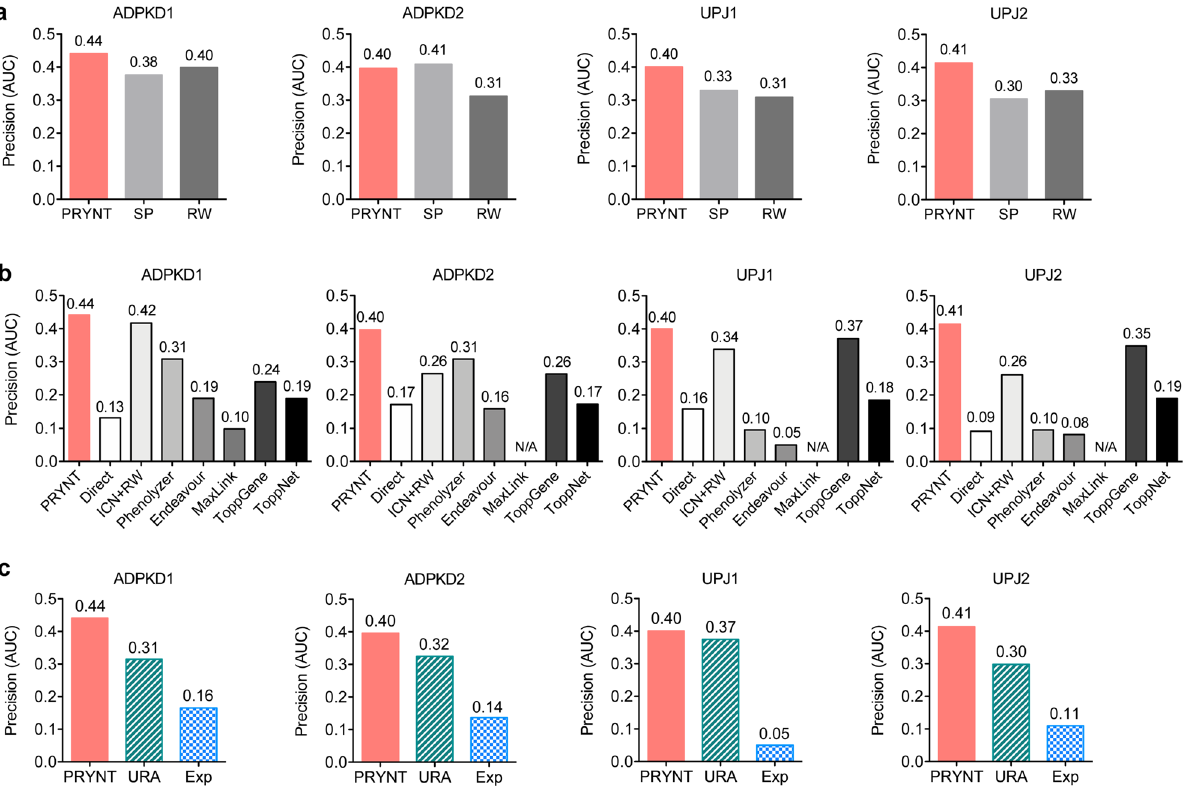
Figure 4. Performance of PRYNT compared to other approaches. PRYNT performance was compared to prioritization using shortest-path or random walk algorithms alone ( a ), to prioritization by other common, state of the art prioritization strategies ( b ), or to prioritization by reference approaches ( c ). The precision was calculated based on the percentage of reference ADPKD or UPJ disease candidates that were prioritized in the top 100 candidates ranked by the different strategies in the four datasets. The corresponding area under the precision curve (AUC) was then calculated. Graphs were designed using GraphPad Prism version 5.0 for Mac, GraphPad Software, San Diego, California USA, http://www.graph pad.com. SP: shortest-path; RW: random walk; D: direct; ICN + RW: interconnectedness combined with random walk; Exp: experimental; URA: upstream regulator analysis.